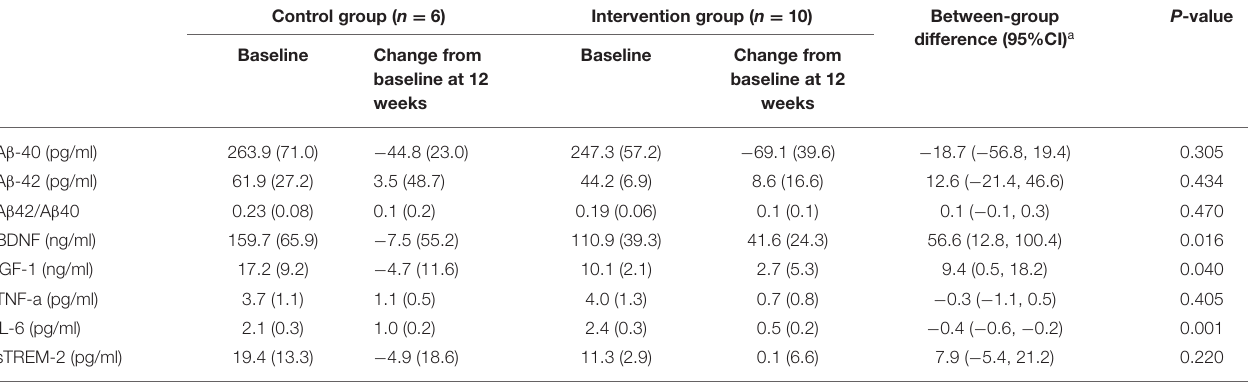
TABLE 4 | Adjusted comparison of neurobiological measurements between changes from baseline at 12 weeks after intervention in patients with MCI ( n = 16). P -value Control group ( n = 6) Intervention group ( n = 10) Between-group difference (95%CI) a Baseline Change from Baseline Change from baseline at 12 baseline at 12 weeks